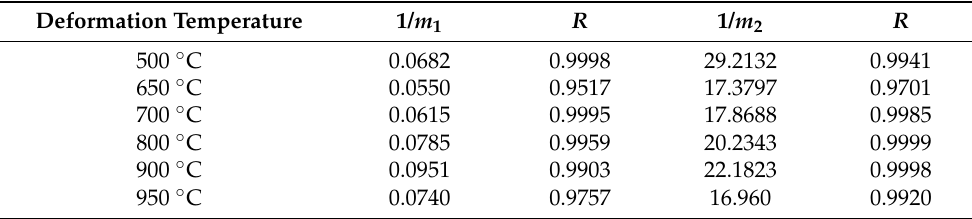
Figure 13. Curves of ( a ) 𝑙𝑛 𝜎 − 𝑙𝑛𝜀̇ and ( b ) 𝜎 − 𝑙𝑛𝜀̇ . Table 4. Fitting results of 1/ m 1 and 1/ m 2 .